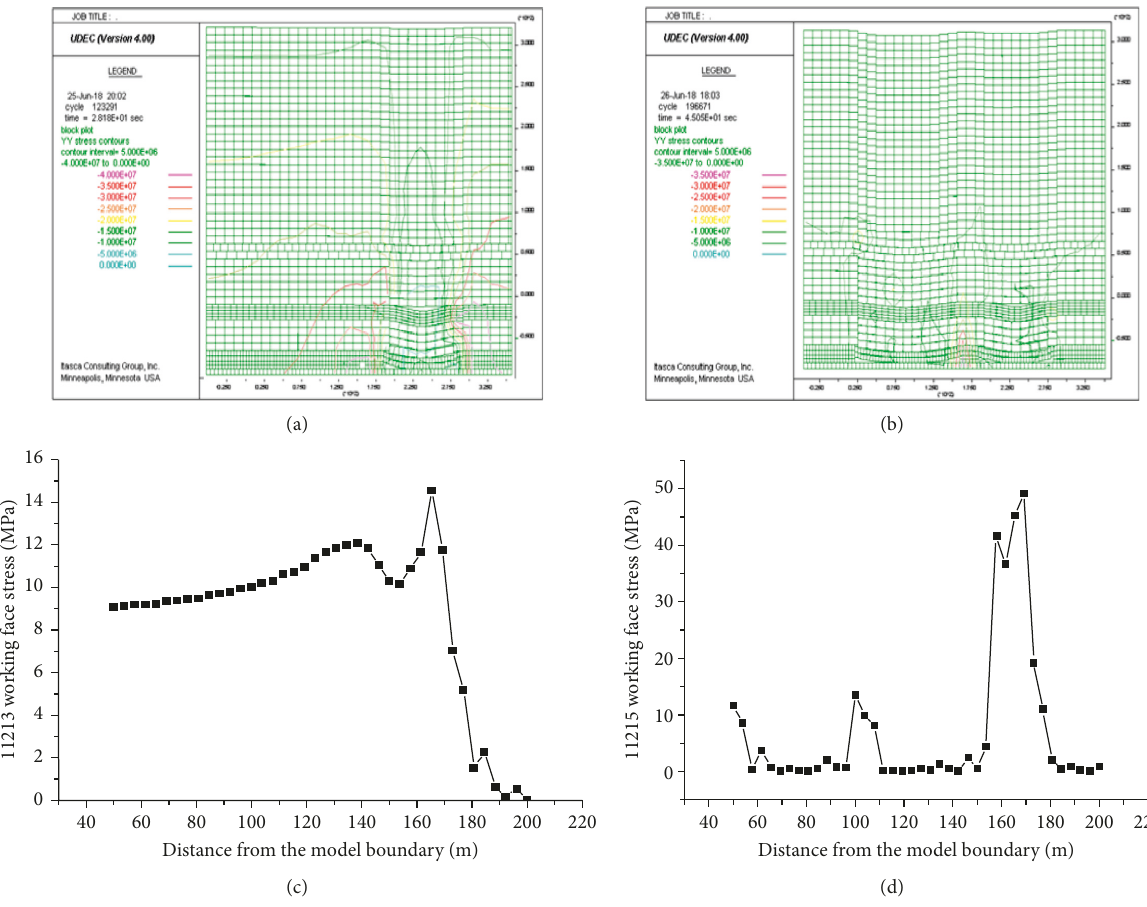
Figure 13: Roof breaking and stress evolution: (a) 11213 working face excavation; (b) 11215 working face excavation; (c) stress distribution of the 11213 working face excavation; (d) stress distribution of the 11215 working face